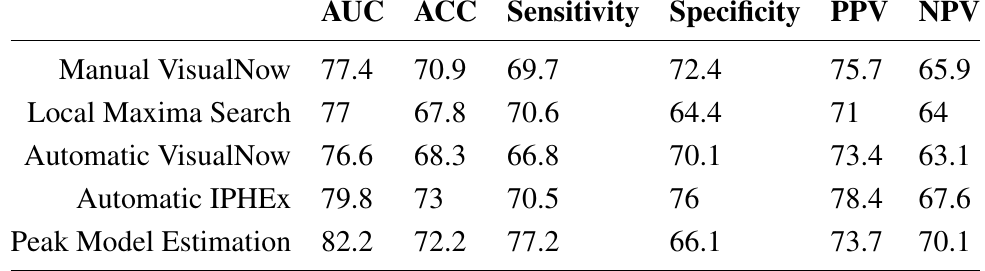
Table 3. Classification Results of the linear support vector machine. The quality measures are the AUC, accuracy (ACC), sensitivity, specificity, positive predictive value (PPV) and negative predictive value (NPV).